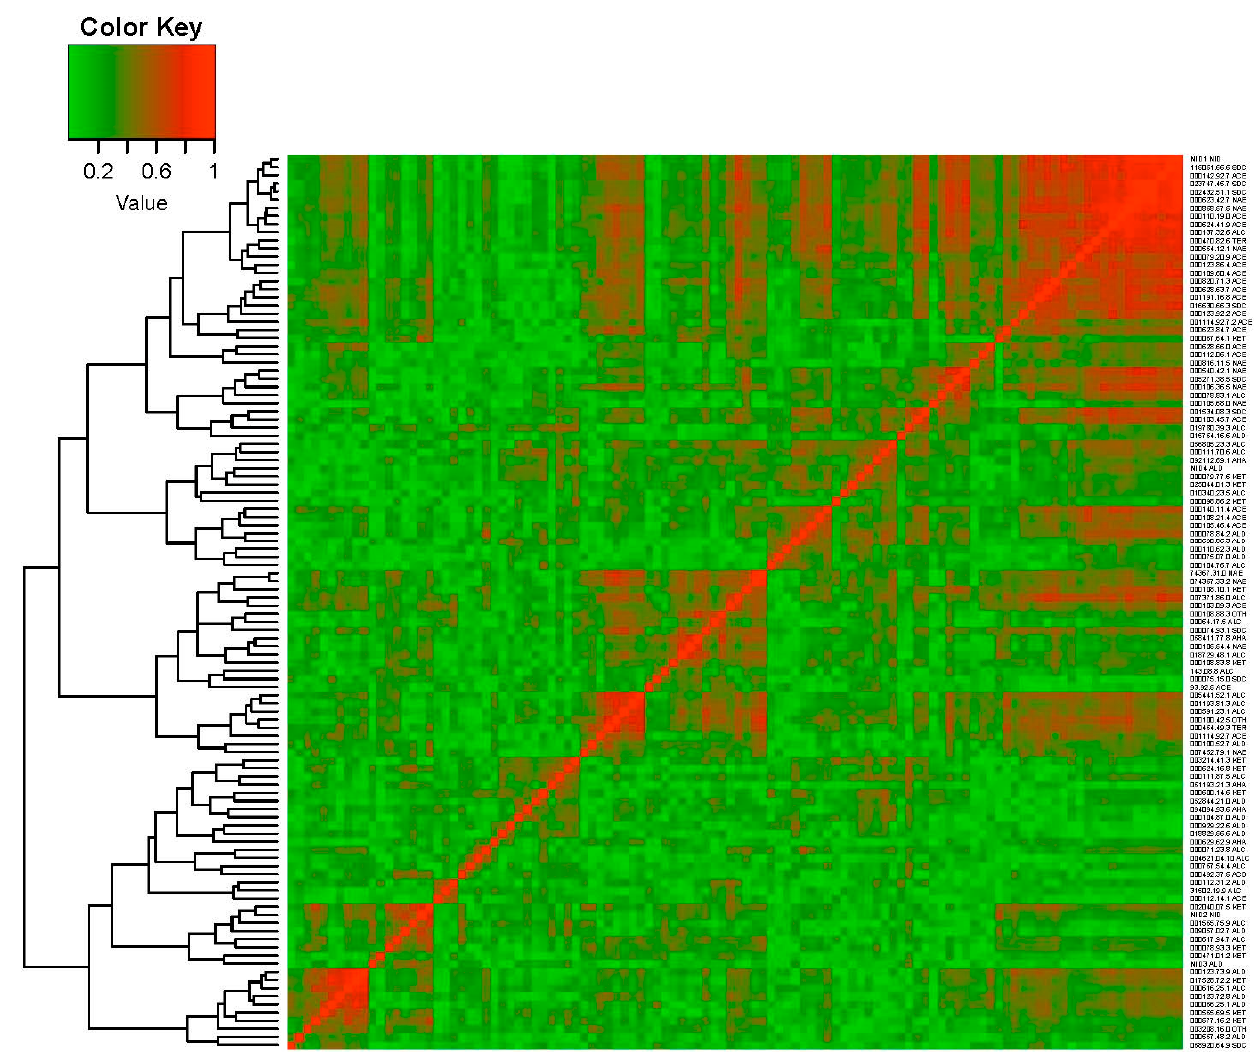
Figure 6. Heatmap of absolute Pearson correlation coefficients between pairs of individual volatile compounds was analyzed for the Near-Isogenic Lines (NILs) with introgression on melon chromosome 3 (SC3-5-7, SC3-5-8, SC3-5-12, SC3-5-13, and SC3-5-14) and the parental control ‘Piel de Sapo‘ (PS). Dendrogram obtained by Ward’s hierarchical clustering method was applied to the log 2 -transformed data. The individual volatiles are plotted by their respective CAS numbers (dots instead of dashes) on the right of the heatmap.